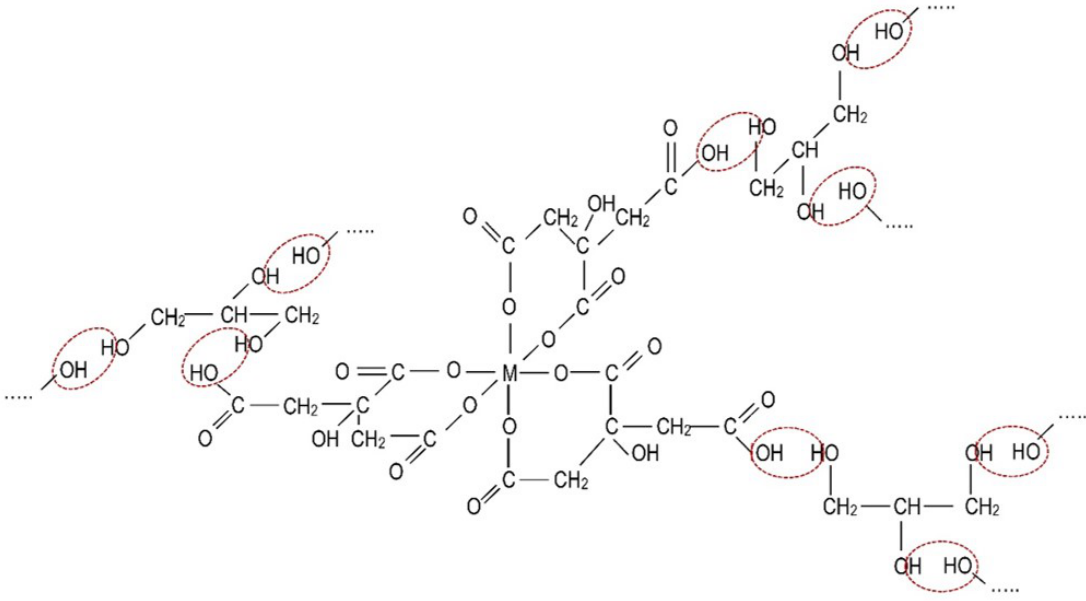
Figure 3. Scheme of the formation of the citrate–glycerin gel.